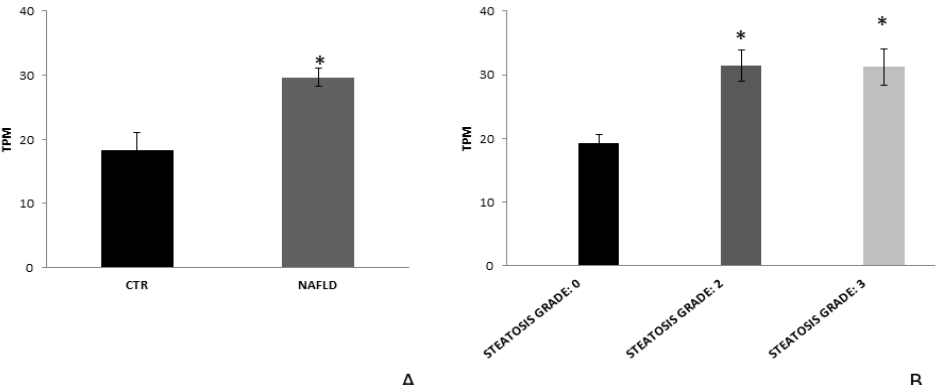
Figure 5. FZD7 mRNA expression in liver tissue from NAFLD patients. ( A ) FZD7 expression data were obtained from the analysis of RNA sequencing of liver tissue from the 72 patients with severe NAFLD and from the 6 controls, downloaded from Gene Expression Omnibus database (GSE130970). ( B ) FZD7 expression data in the same cohort of NAFLD patients divided according to steatosis grade, including the 42 patients with moderate NAFLD and 71 with severe NAFLD. Mean expression data were expressed in TPM (transcripts per million). * p < 0.05.